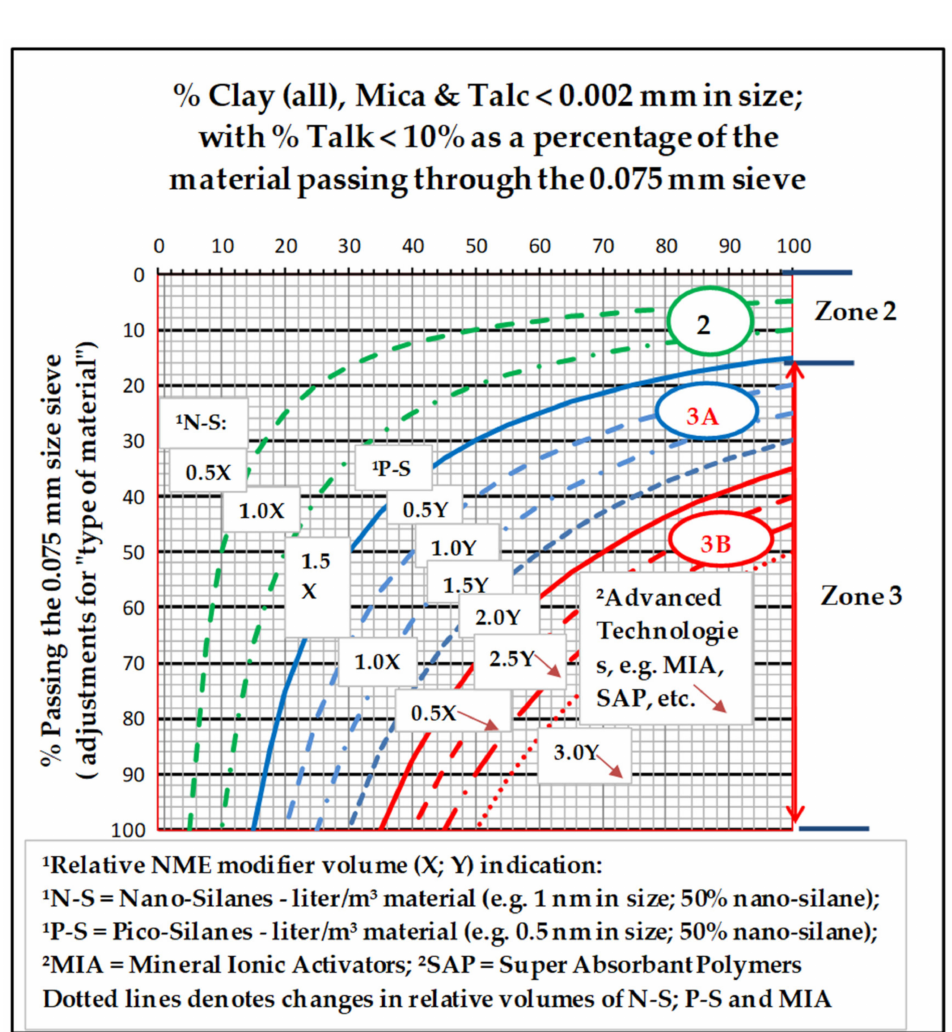
Figure 20. Selection of relative volumes of nano-silane modifications and high-quality, high-purity pico-silane modifying agents required to address the surface area of the naturally available